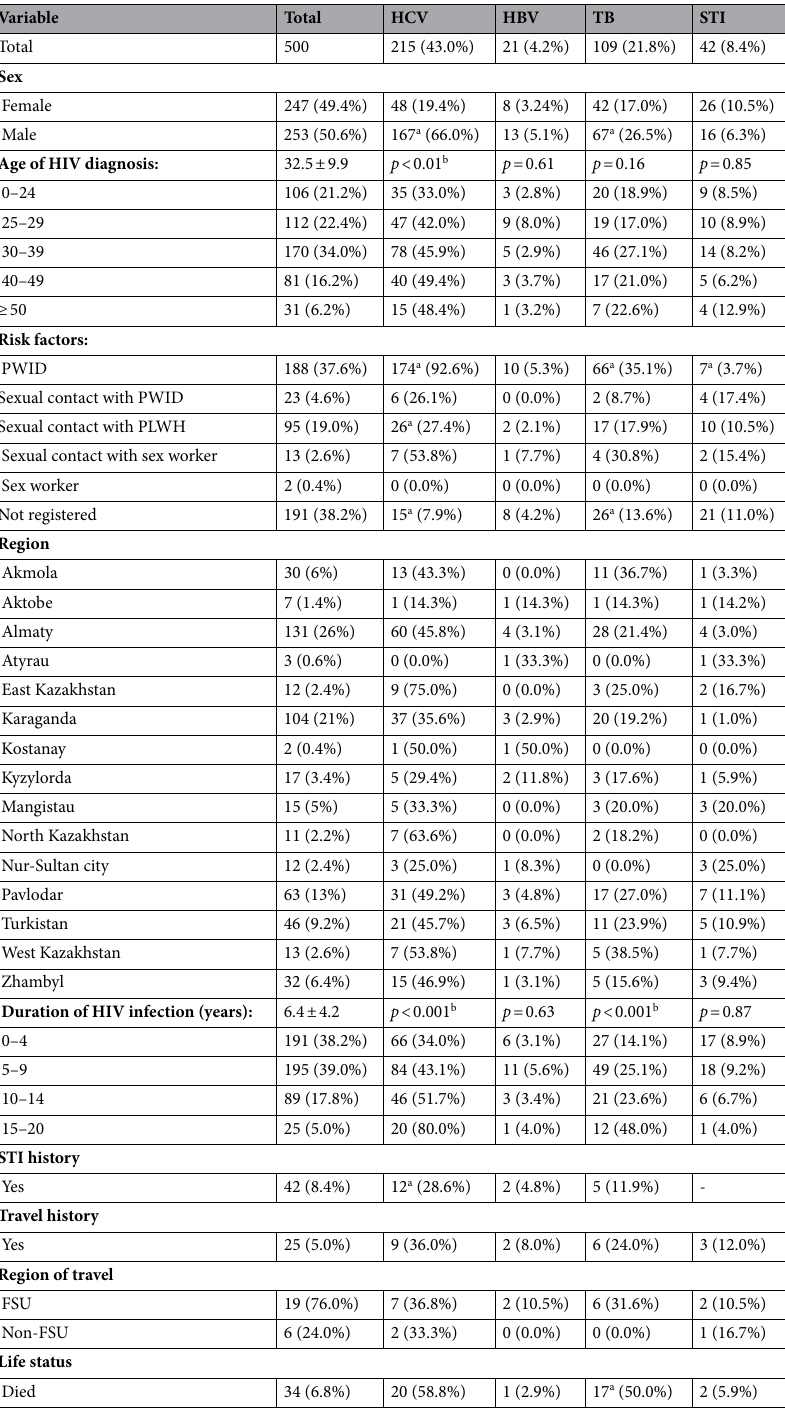
Table 1. Factors associated with HCV, HBV, TB and STI co-infections among 500 HIV-positive patients. a p -value < 0.05 from Chi-square and Fisher’s exact tests. b p -value < 0.05 from two-tailed t-test. HIV, human immunodeficiency virus; HCV, hepatitis C virus; HBV, hepatitis B virus; TB, tuberculosis; STI, sexually transmitted infection; PWID, people who inject drugs; PLWH, people living with HIV; FSU, former Soviet